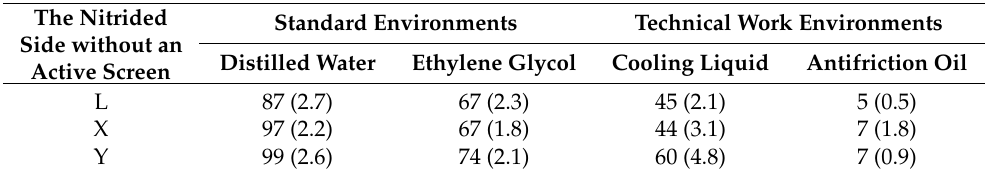
Table 7. The values of the contact angles on different angular surfaces and error bars in the brackets for the plasma nitrided samples with an active